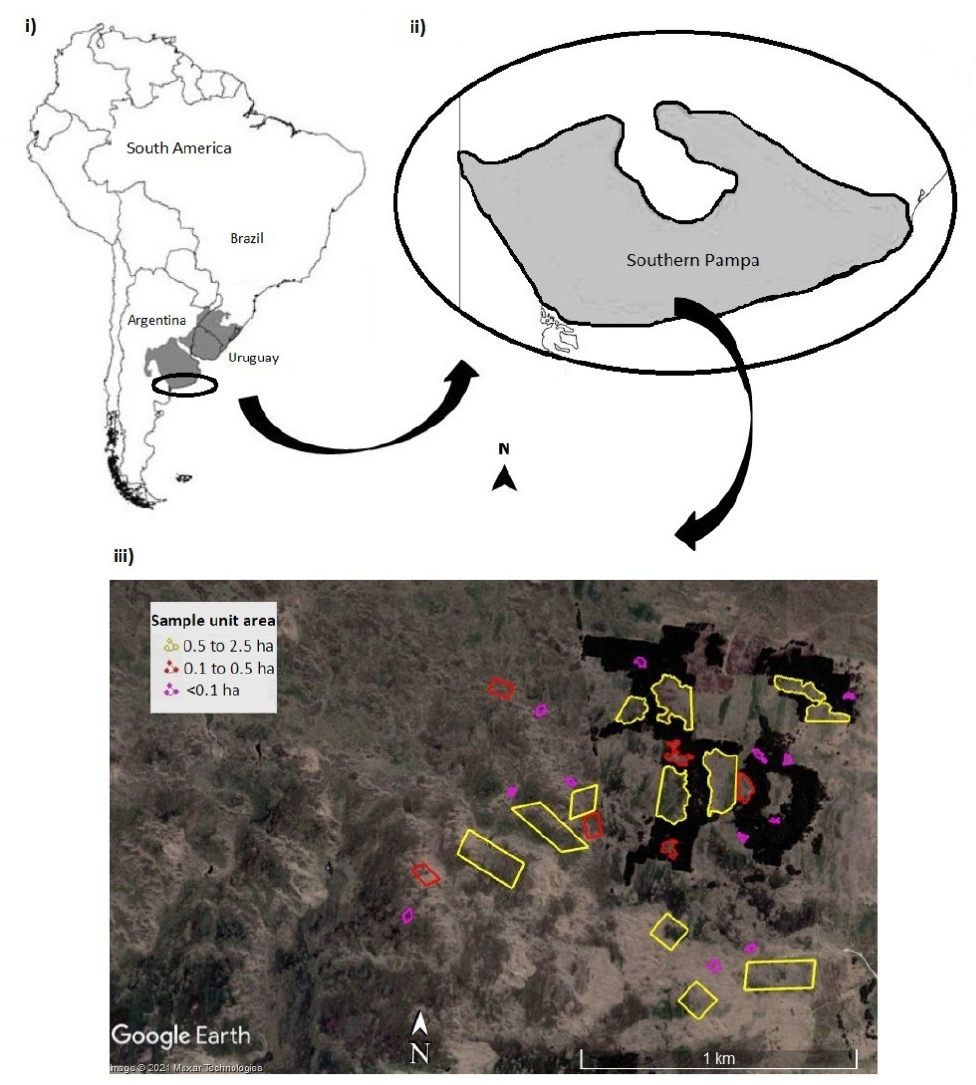
Figure 1. Location of the study area in the coastal grasslands of the southern Pampa, Buenos Aires, Argentina ( i , ii ). The arrangement of the samples of different sizes (less than 0.1 ha, 0.1 to 0.5 ha and 0.5 to 2.5 ha) is indicated, including fragments surrounded by afforestation and controls in the continuous grassland ( iii ). In gray, delimitation of the Grasslands of the Río de la Plata (Adapted from Soriano et al. (1992)). Image from Google Earth (2021).